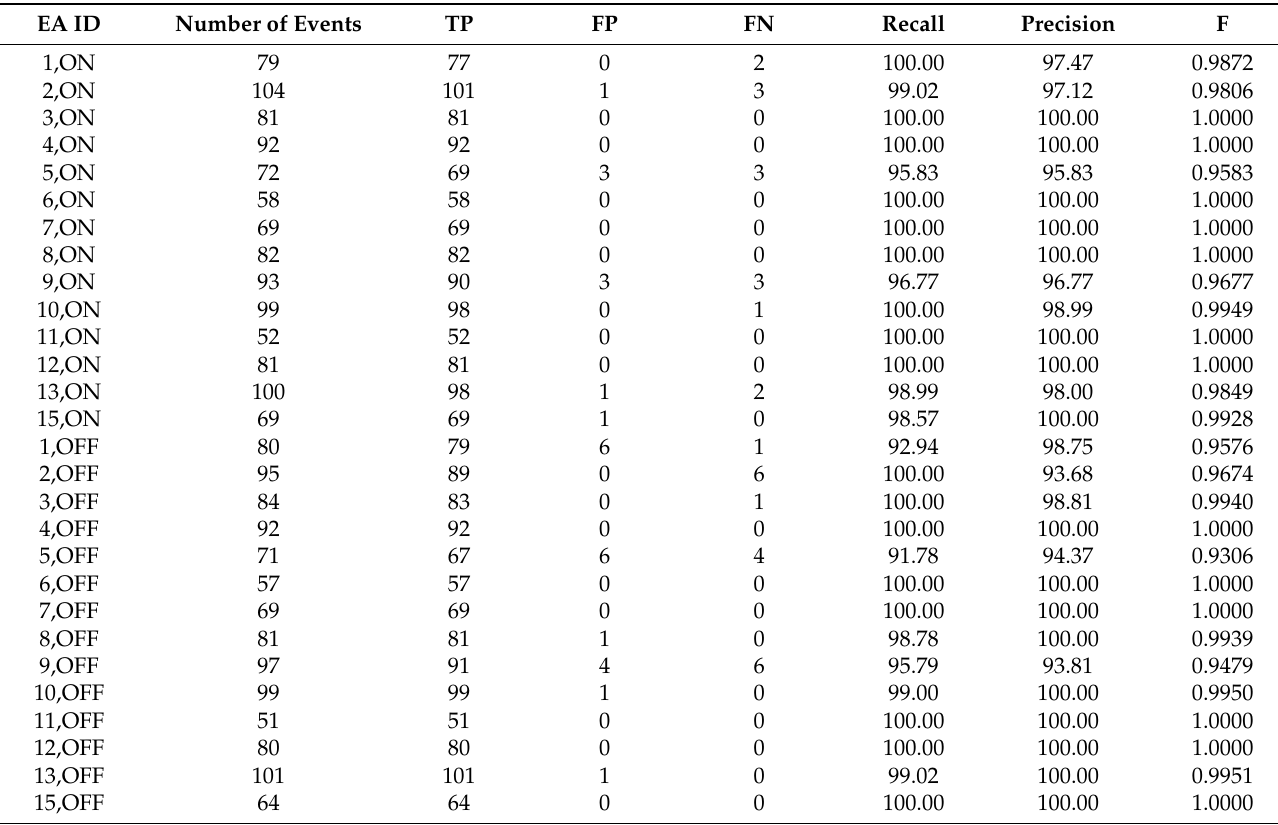
Table 6. Appliance recognition results with known time instant of the state